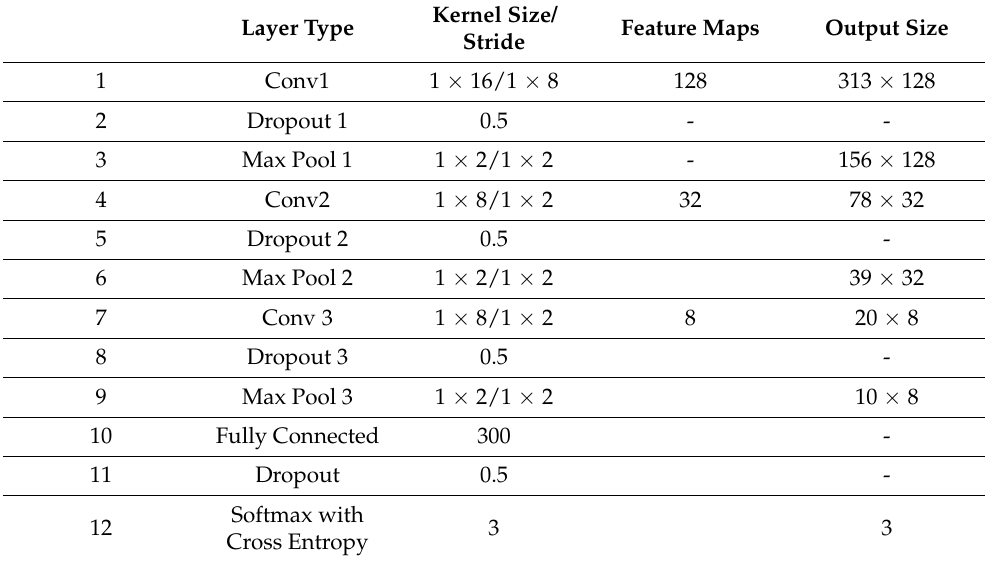
Table 3. Parameters of the